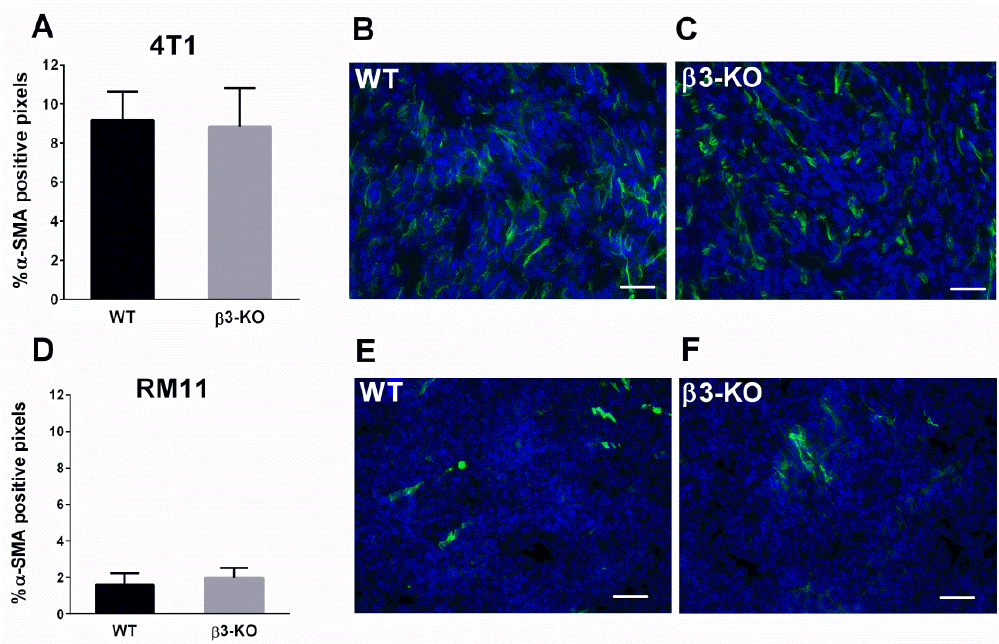
Figure 4. Percentage of pixels positive for α-SMA in 4T1 ( n = 5) and RM11 ( n = 4) tumors ( A , D ) from WT and β3-KO mice were calculated from immunofluorescent images. No statistical differences in 4T1 ( p = 0.76) or RM11 ( p = 0.34) tumors were found. Mean ± SD. Representative images of α-SMA-staining (green) from both genotypes in 4T1 ( B , C ) and RM11 ( E , F ) tumors are shown. Scale bars indicate 50 µm.